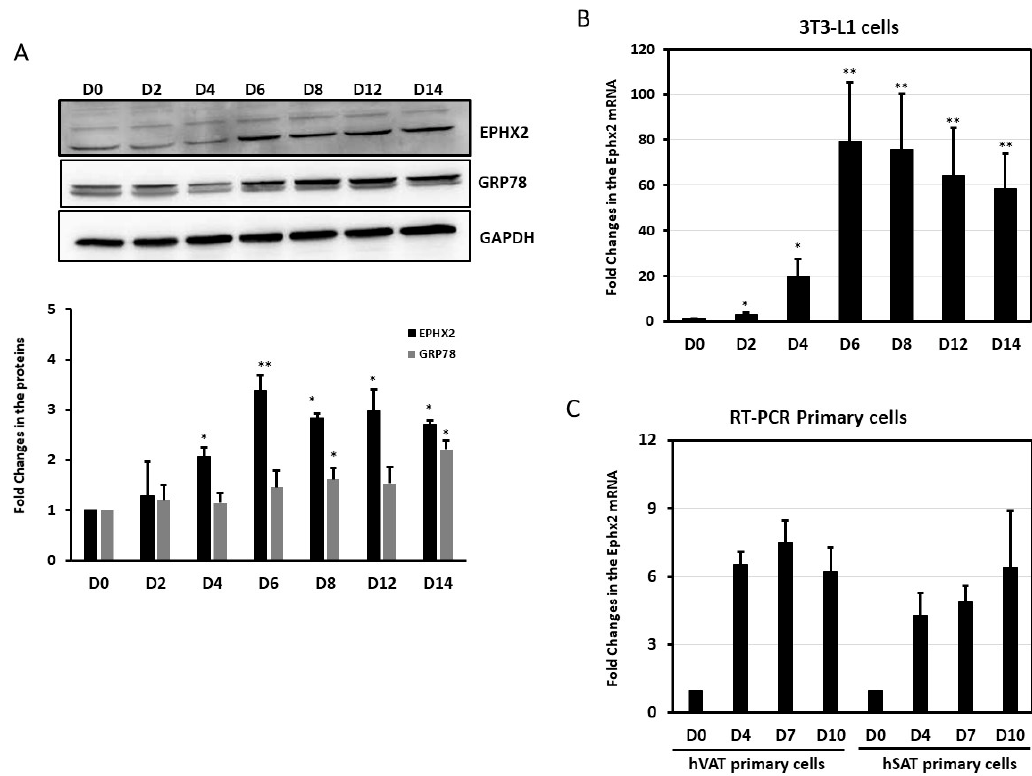
Figure 3. Expression levels of EPHX2 during di ff erentiation of preadipocytes. Protein ( A ) and mRNA ( B ) levels were measured by Western Blot and quantitative real-time PCR, respectively, in 3T3-L1 preadipocytes (D0) and adipocytes di ff erentiated for 14 days (D2–D14) from three independent experiments. ( C ) mRNA levels were measured by quantitative real-time PCR in human visceral (hVAT), subcutaneous (hSAT) preadipocytes (D0), and adipocytes di ff erentiated for 10 days (D4–D10) from two independent experiments. Data are presented as the fold change in di ff erentiated adipocytes compared with preadipocytes (D0). * p < 0.05; ** p <